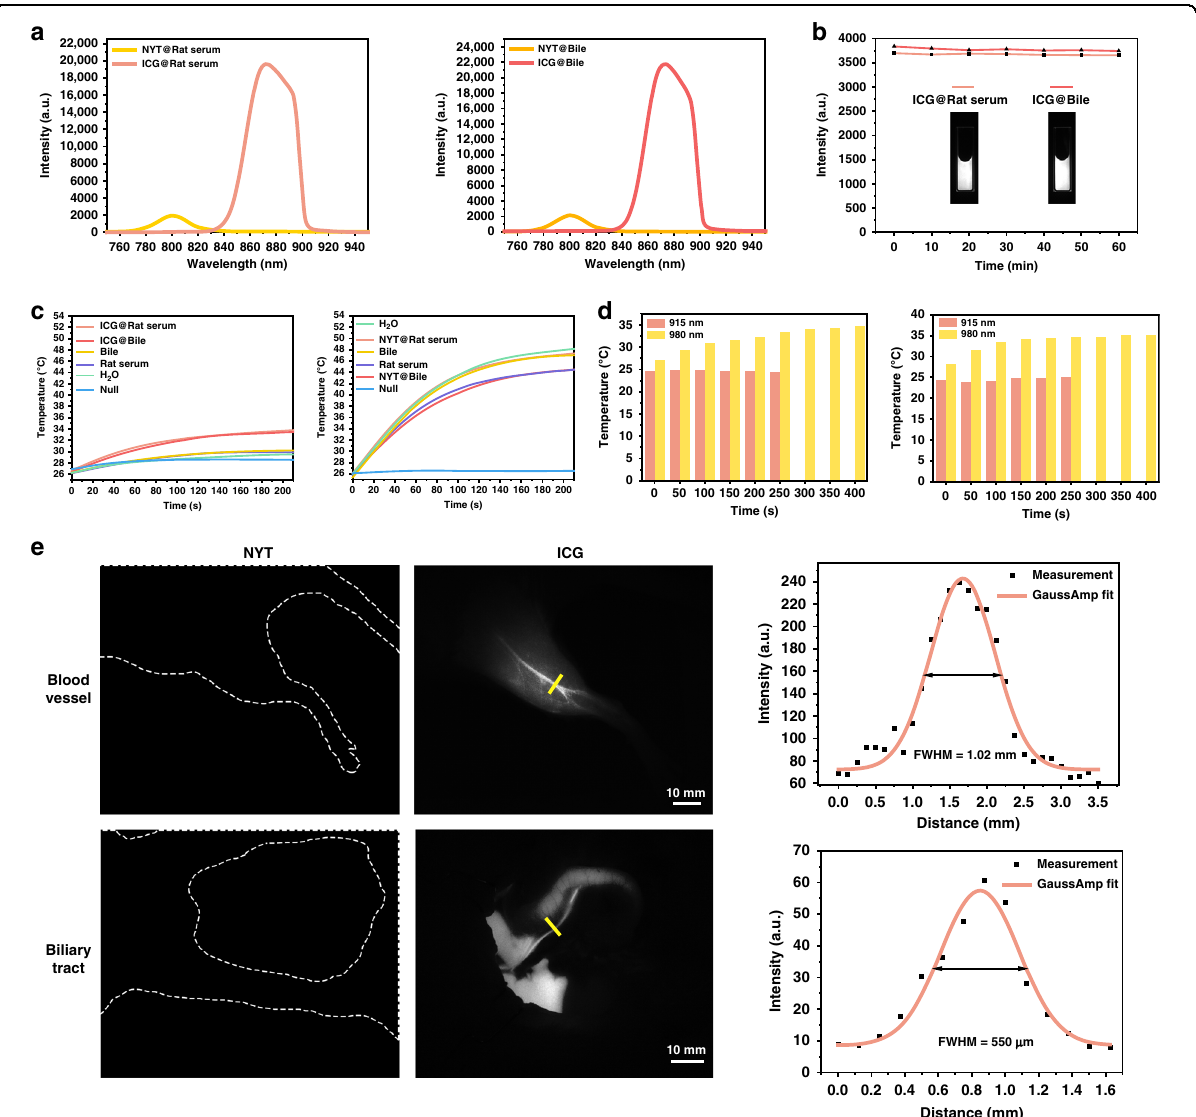
Distance (mm) Fig. 3 Comparison of ASF performances of ICG and NaYF 4 : Yb 3 + , Tm 3 + in vitro and in vivo. a ASF spectra of ICG (0.1 mg mL − 1 ) and NaYF 4 : Yb 3 + , Tm 3 + (1 mg mL − 1 ) in rat serum and rat bile. Excitation: 915 nm CW laser (0.9 W cm − 2 ) for ICG, 980 nm CW laser (1.8 W cm − 2 ) for NaYF 4 : Yb 3 + , Tm 3 + ; integration time: 0.5 s for ICG, 4 s for NaYF 4 : Yb 3 + , Tm 3 + . b Photostability of ICG (0.1 mg mL − 1 ) in rat serum and rat bile under the continuous irradiation of 915 nm CW laser (68 mW cm − 2 ) for one hour. Insert: the corresponding ASF images, fl uorescence collection range: 800 – 900 nm, exposure time: 25 ms. c In vitro measurements of photothermal effects for simulating the in vivo experimental scenes. ICG Group (left): 915 nm CW laser (1.8W cm − 2 ) irradiation, NaYF 4 : Yb 3 + , Tm 3 + group (right): 980 nm CW laser (1.8 W cm − 2 ) irradiation. d The photothermal effects on rats ’ hind limbs (left) and livers (right) in in vivo wide- fi eld imaging, using ICG excited by the 915 nm CW laser (16.5 mW cm − 2 ) or directly irradiating with the 980 nm CW laser (0.6 W cm − 2 ). e In vivo ASF wide- fi eld imaging of blood vessels and biliary tracts of two rats after receiving an injection of NaYF 4 : Yb 3 + , Tm 3 + and ICG respectively. Imaging conditions: 980 nm CW laser (57 mW cm − 2 ) irradiated on the rat injected with NaYF 4 : Yb 3 + , Tm 3 + (9.6 mg mL − 1 , 500 μ L); 915 nm CW laser irradiated on the hind limb (16.5 mW cm − 2 ) and the biliary tract (4.5 mW cm − 2 ) of the rat injected with ICG (1 mg mL − 1 , 500 μ L); fl uorescence collection range: 800 – 900 nm; exposure time: 25 ms. The FWHMs of the blood vessel (1.02 mm) and the biliary tract (550 μ m) along yellow solid lines were measured. Scale bar: 10 mm. Abbreviations: NYT NaYF 4 : Yb 3 + , Tm 3